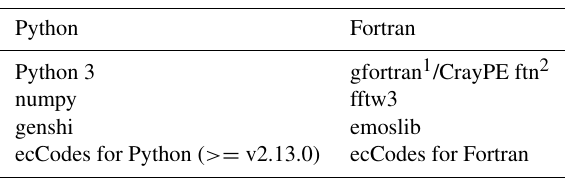
Table 7. Software dependencies for flex_extract in all application